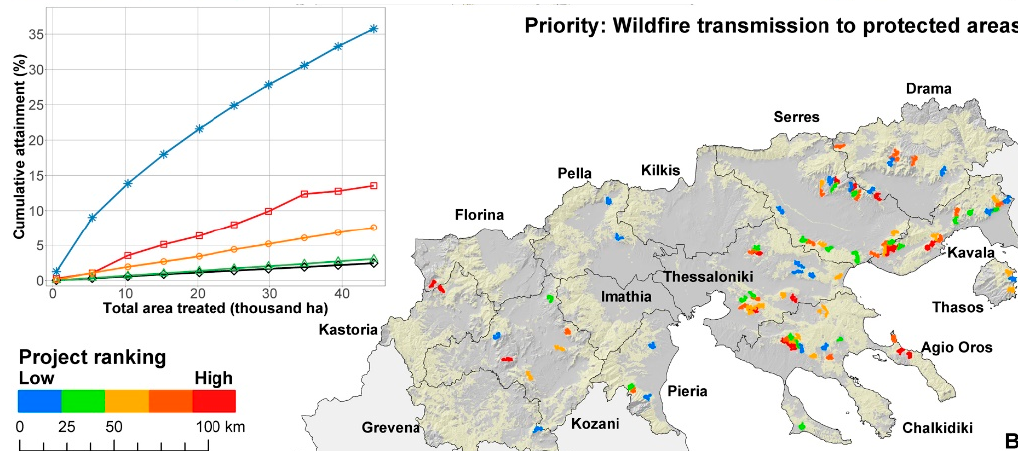
Figure 5. ( A ) Prioritization of suppression difficulty. ( B ) Prioritization of wildfire transmission to protected areas. All projects were ranked from lowest to highest attainment. Graphs on the left show the cumulative percent attainment of each of the five priorities if the 100 projects on each map receive fuel treatments.